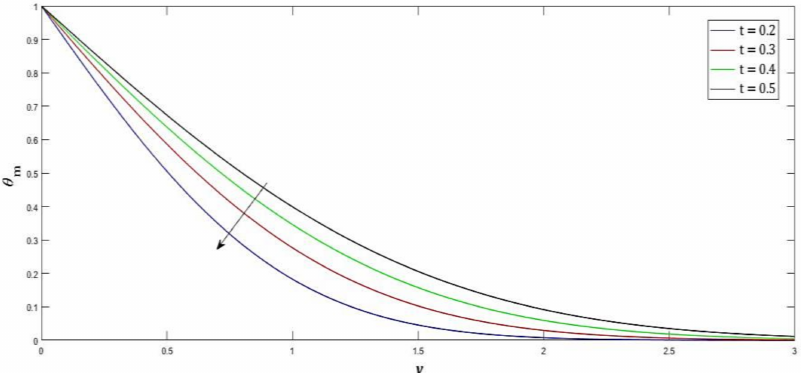
Figure 8. Variation in temperature profile with respect to